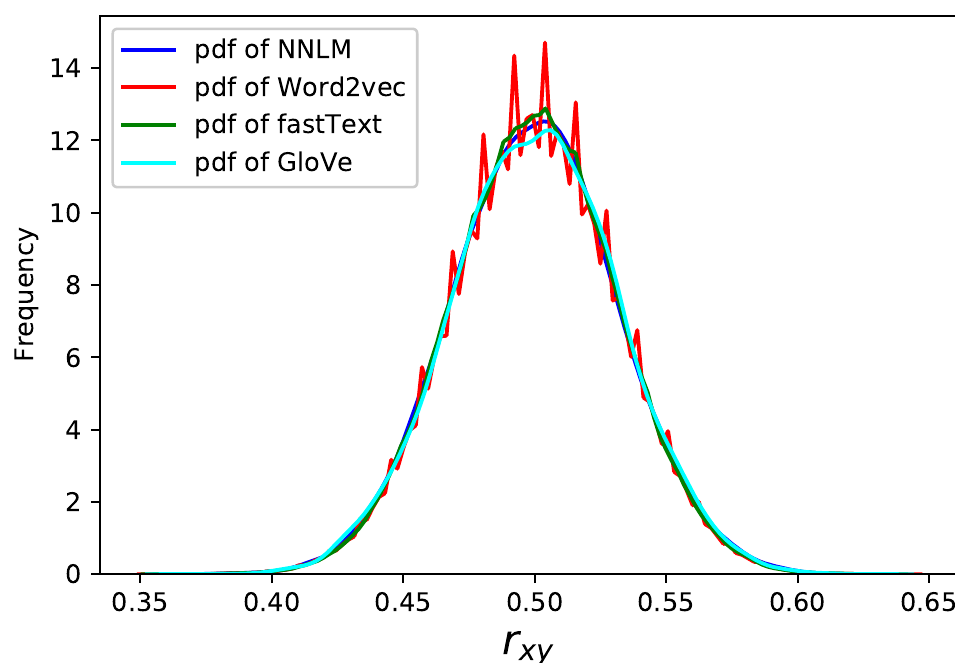
Figure 19. Generality about models to be